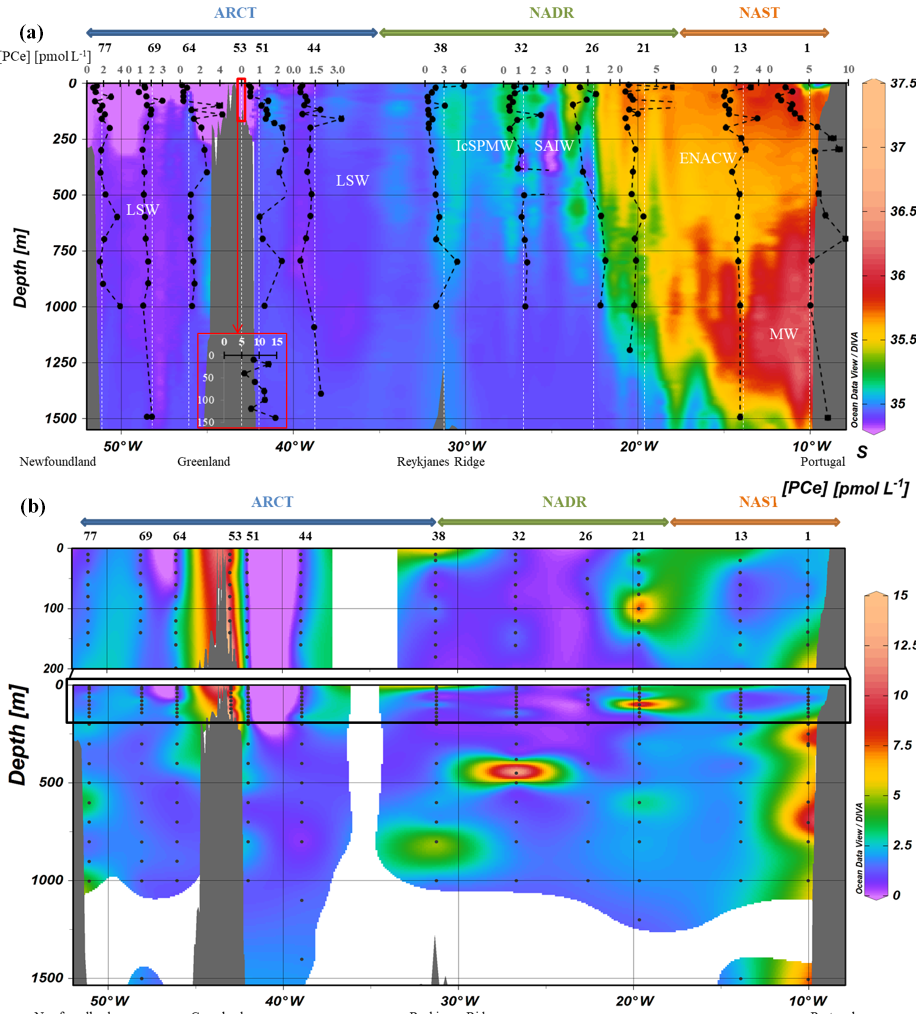
Figure 2. (a) Vertical profiles of particulate [Ce] concentrations superimposed on salinity ( S ) measured by CTD at every GEOVIDE station (Lherminier and Sarthou, 2017); in white, the prevailing water masses characterized by a multi-parametric (OMP) analysis: the Mediterranean Water (MW), the Subarctic Intermediate Water, the East North Atlantic Central Water (ENACW), the Subpolar Mode Water (SPMW), the Irminger Subpolar Mode Water (IrSPMW), and the LSW (García-Ibáñez et al., 2018). For station no. 53, profiles are shifted to the bottom at a lower scale because of the shallow depth of the station. This map and the following were created with the software Ocean Data View (Schlitzer, 2016). (b) Particulate [Ce] concentrations interpolated with the DIVA gridding function of Ocean Data View along the section defined in Fig. 1, with a zoom on the first 200m in the upper